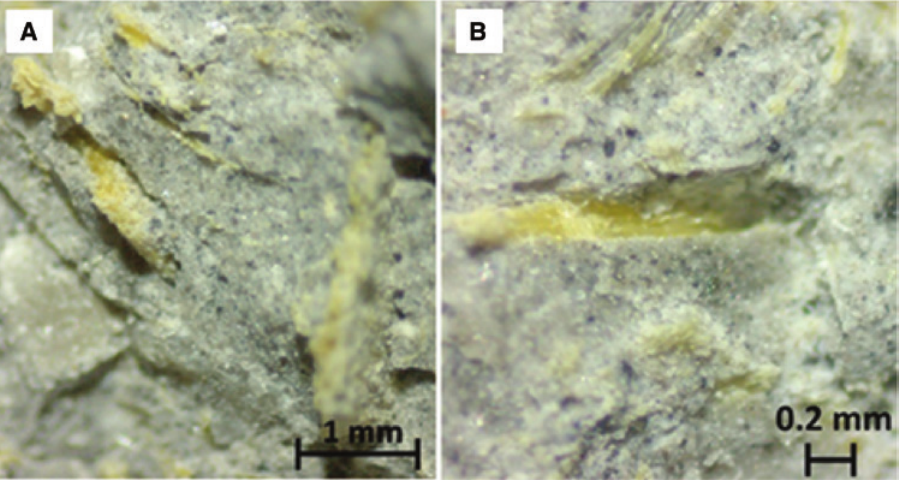
Figure 10: Stereoscope images of mortar with (A) 70% by volume replacement of fine aggregates by ayous shavings and (B) 20% by volume replacement of fine aggregates by beech